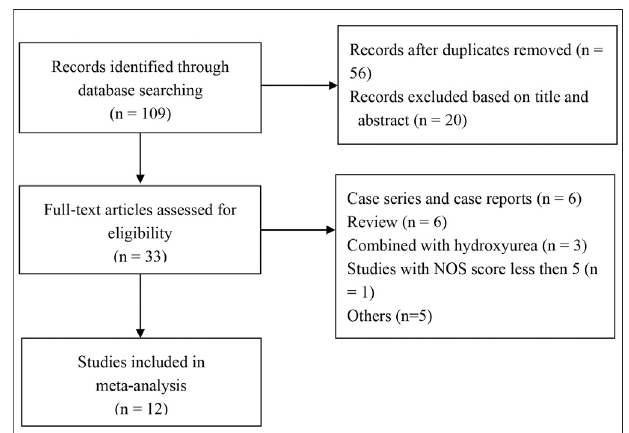
FIGURE 1 | Flowchart of study selection process. NOS, Newcastle- Ottawa